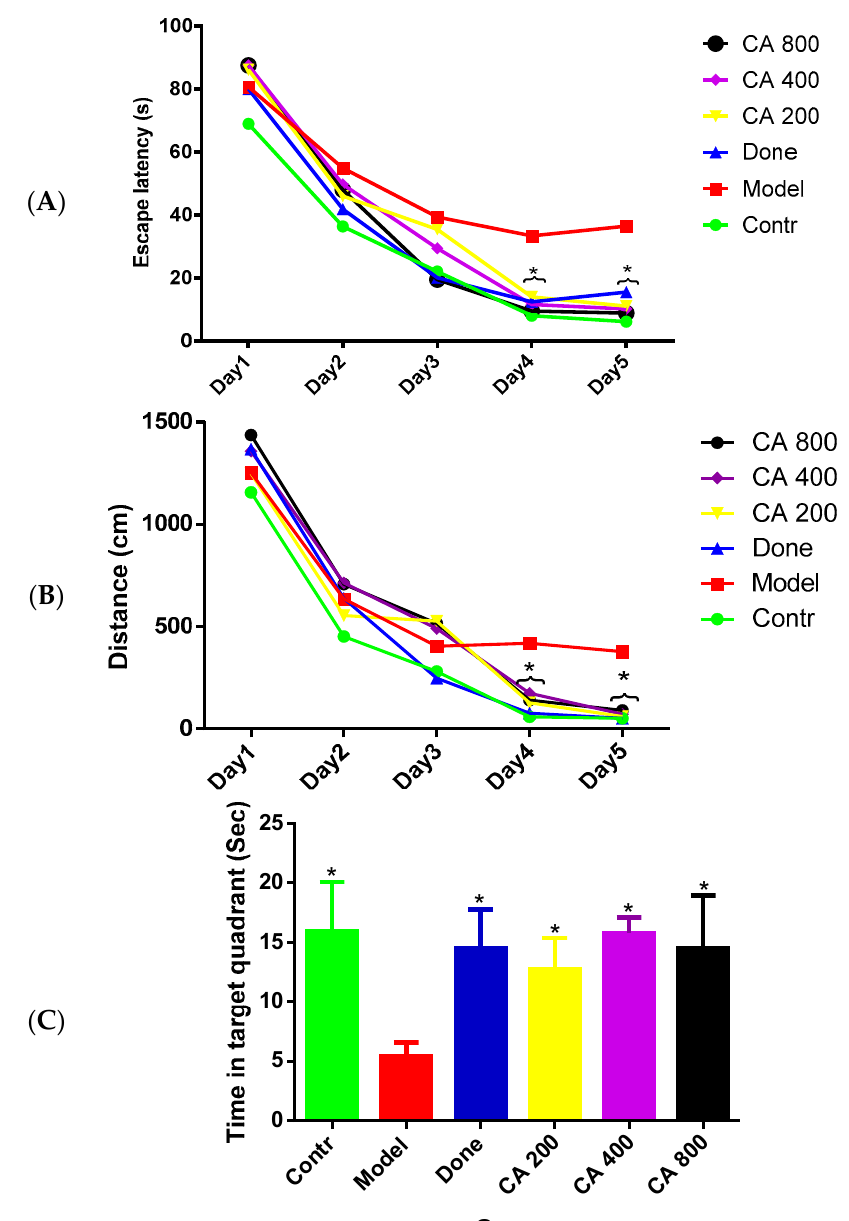
Figure 1. Effects of CA on the behavior of D-gal- and AlCl 3 -induced rats in the Morris water maze (MWM). ( A ) Comparison of escape latency to the submerged escape platform during the five days of training; ( B ) comparison of the distance covered by the rats during the five days of training; and ( C ) comparison of the time spent in the removed escape platform quadrant on day six of the test. Values were presented as mean ± SEM ( n = 6), * p < 0.05 vs. model group.